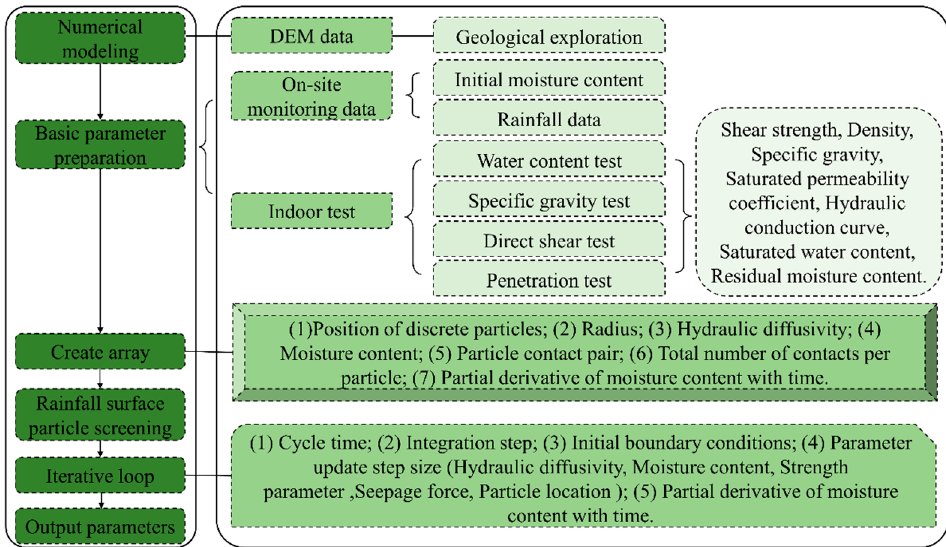
Figure 1. Rainfall infiltration simulation